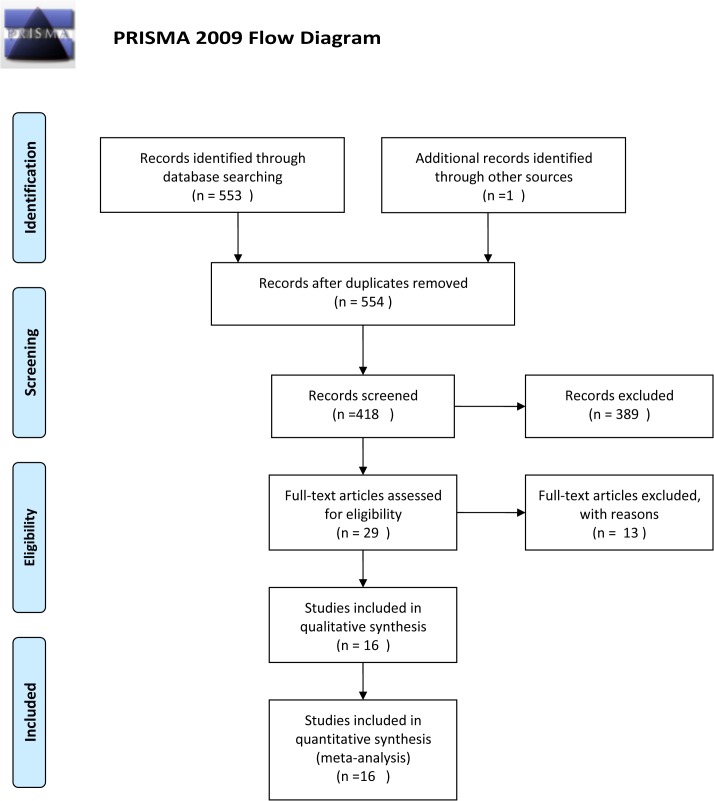
Flowchart of the study’s selection process.